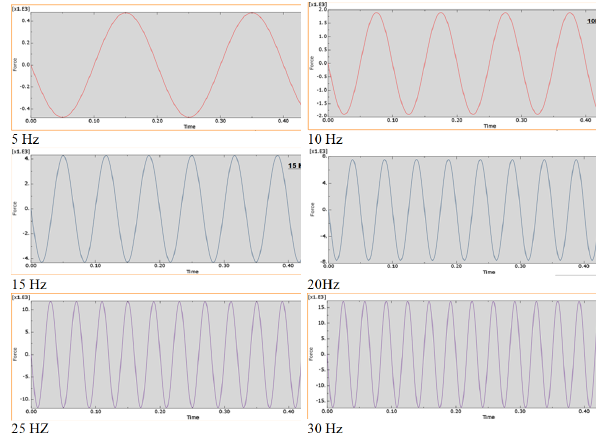
Plate 4: Specimens set up